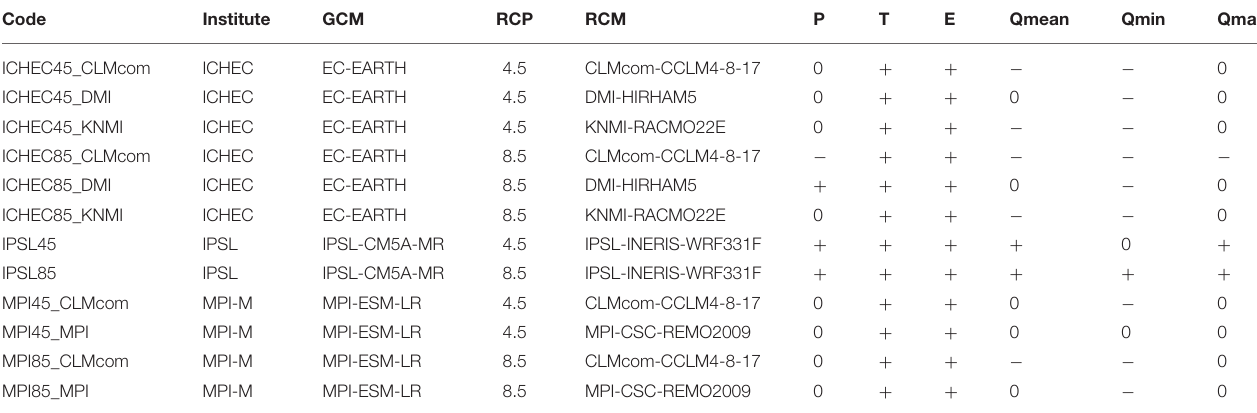
TABLE 1 | List of GCM, RCP and RCM combinations used in this study, as well as the climate variable (precipitation P, temperature T, potential evapotranspiration E) and associated hydrological variables (Qmean, mean annual 10-day streamflow; Qmin, minimum annual 10-day streamflow; Qmax, maximum annual 10-day streamflow) change trends for the 1952–2100